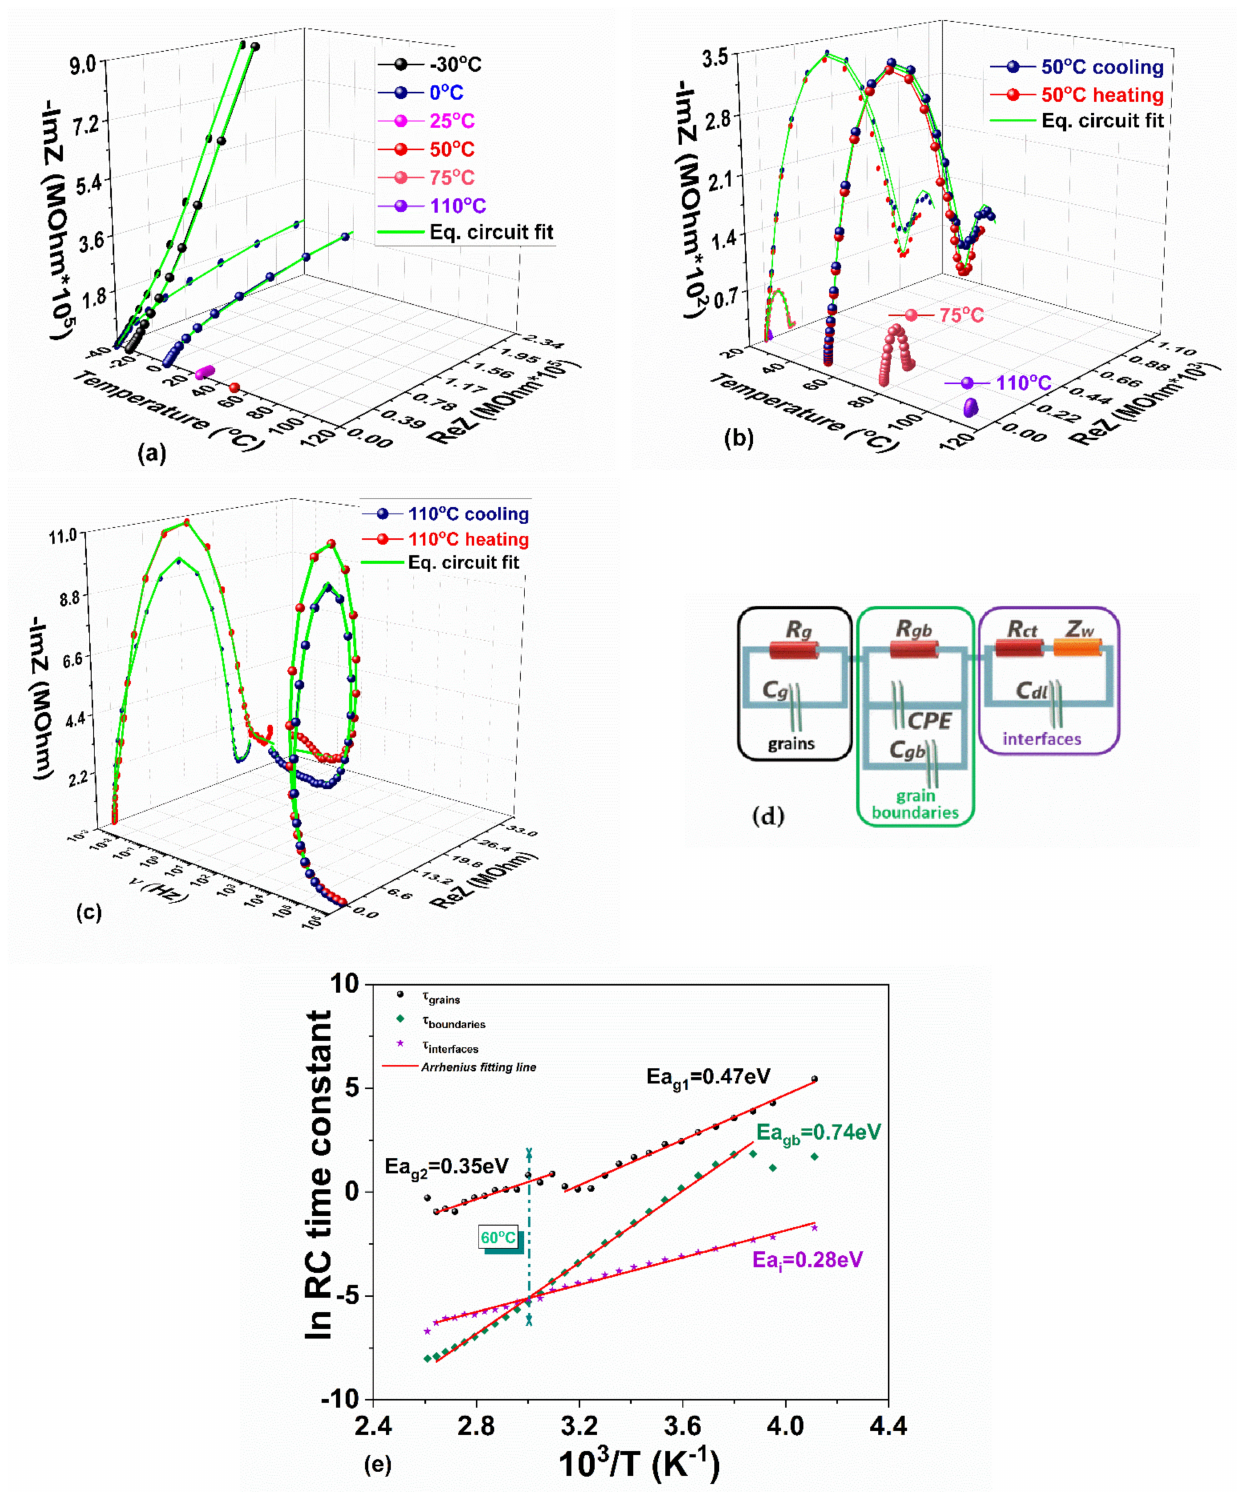
Figure 13. ( a ) Nyquist spectra for a few selected temperatures in the range of − 30 ◦ C and 110 ◦ C together with ( b ) zoom for higher temperatures and ( c ) zoom for 110 ◦ C for both paths of heating and cooling; ( d ) the equivalent circuit used for fitting the Nyquist spectra; ( e ) Arrhenius-like activation energies of the time constant related to grain, grains boundary and